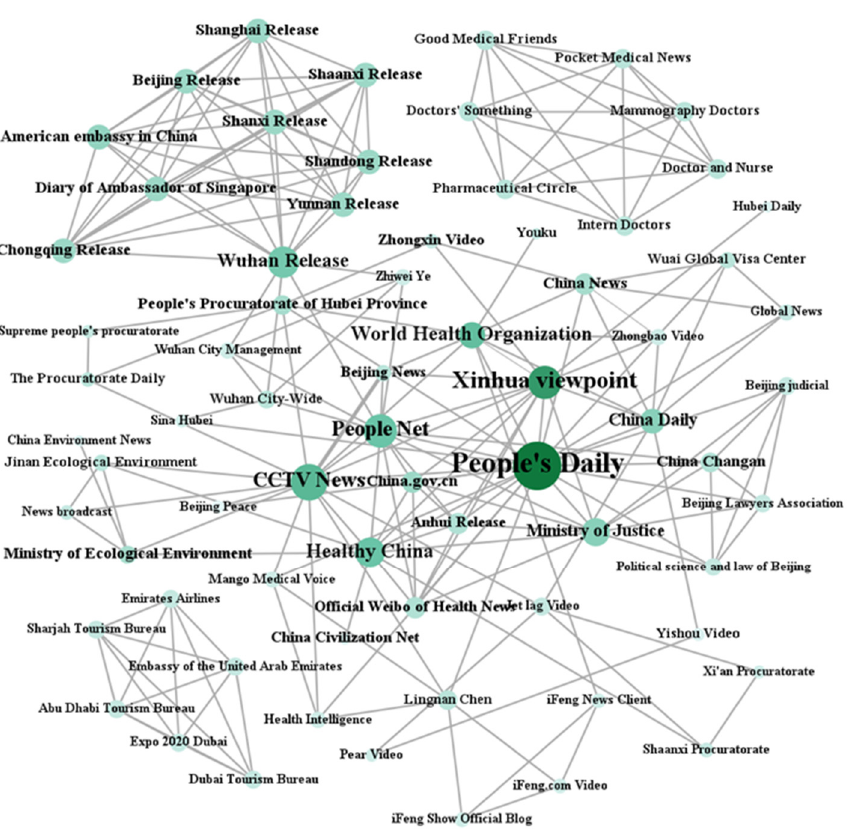
Figure 5. Whole network of Weibo. Table 4. Network centrality measurements on Twitter and Weibo.